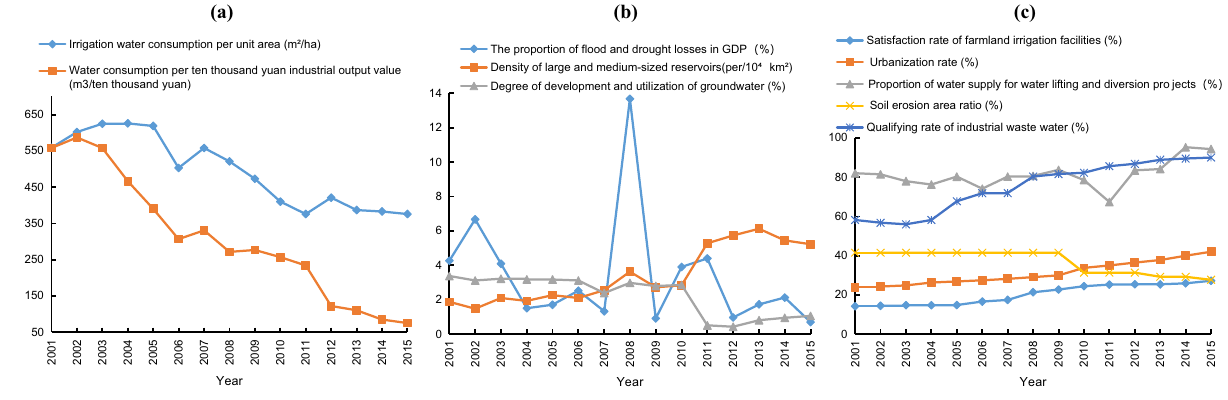
Figure 6. Driving factors of water resource security in the karst area.